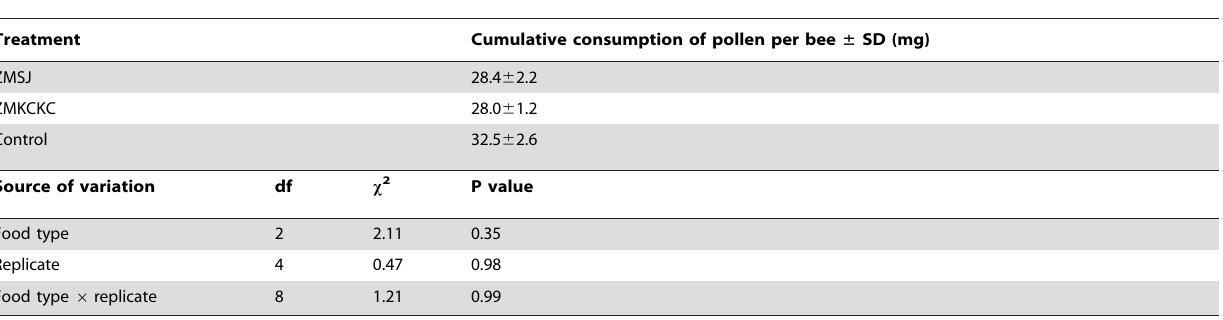
Table 3. Cumulative consumption of pollen by honey bees from groups subjected to chronic exposure to ZMSJ pollen, ZMKCKC pollen and non-Bt pollen after 7